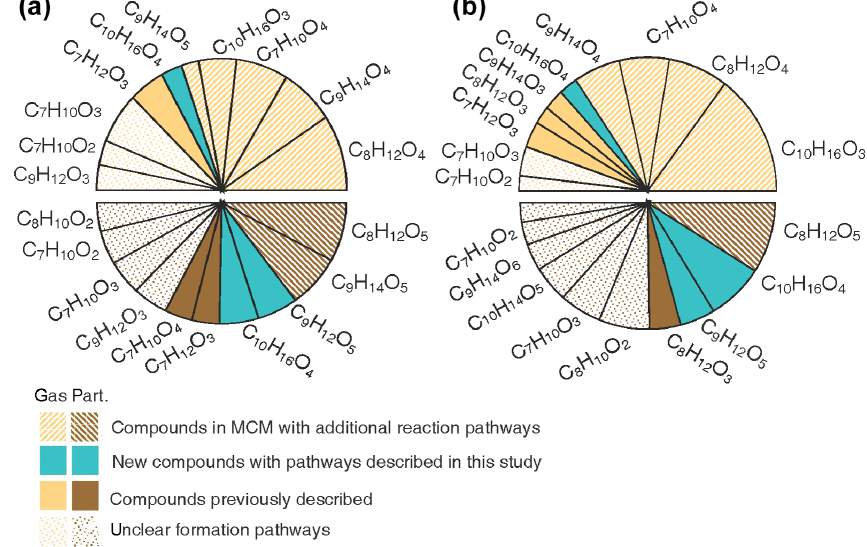
Figure 8. Pie charts showing the percentage contribution of each compound for the 10 major compounds observed. The top half of the pies shows the gas-phase data, and the bottom half of the pies shows the particle-phase data. The compounds are classified according to current knowledge, i.e. previously described reaction mechanism, mechanism suggested in this study and unclear formation pathways. (a) The averaged contribution for all experiments. (b) The specific contributions for Experiment 1, which had the lowest concentrations of reactants with mixed oxidants and humid